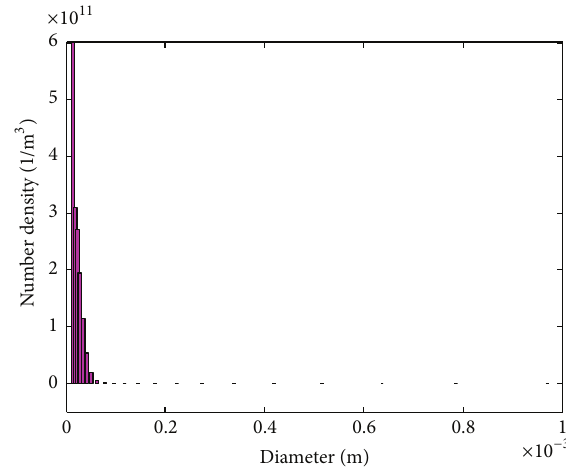
Figure 15: Plot of the number density of bubble in the entire volume for nozzle 1.